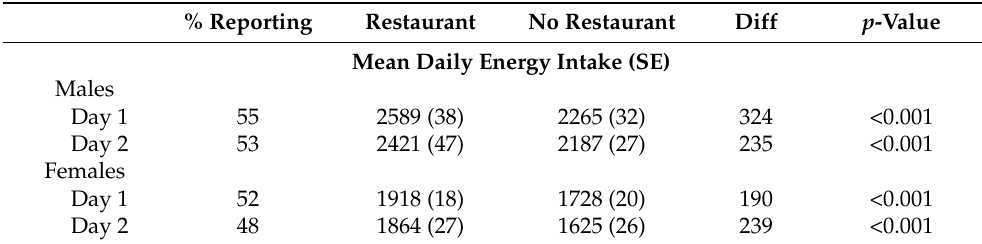
Table 2. Mean daily energy intake differences by restaurant reporting status, sex, and intake day for